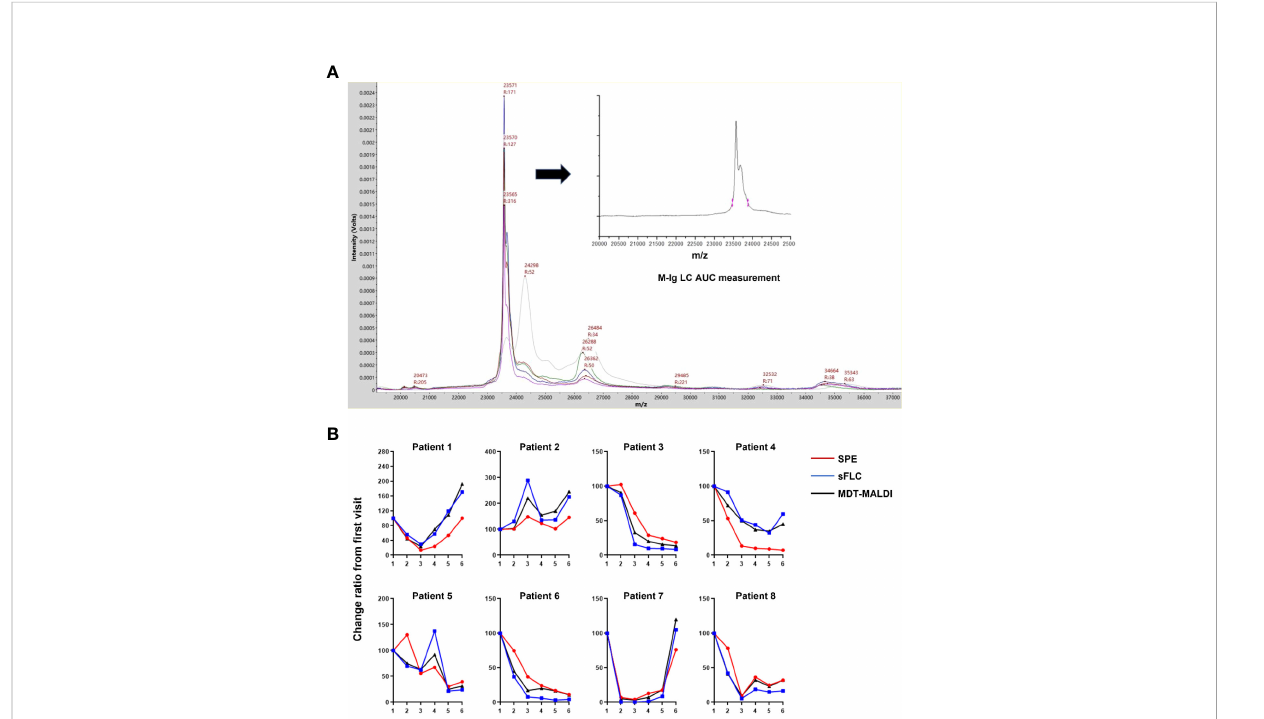
FIGURE 5 Utility analysis of MDT-MALDI in disease monitoring. (A) Mass spectra from the serial serum samples (diagnostic and following post-treatment) of an IgG-L multiple myeloma patient. M-protein concentration change between series samples can be calculated by the AUC measurement for gated LC signal and comparing with the fi rst visit time for disease monitoring. (B) Comparison of the change ratio of M-protein concentrations determined by SPE, sFLC assay and MDT-MALDI. For each assay, the M-protein concentration (M-Ig AUC) at diagnosis was set at 100% and the relative M- protein concentration was calculated for each serial sample. A cohort of 8 patients with a history of multiple myeloma and disease monitoring serum samples were